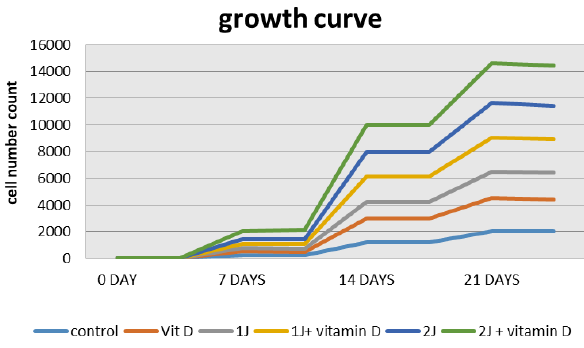
Figure 3: Growth curve for cell counts throughout the study showed a statistically significant difference between all groups (p < 0.05) with 1.5-fold increase in cell count in the 2 J/cm 2 + vitamin D group (group VI) that in the control group.